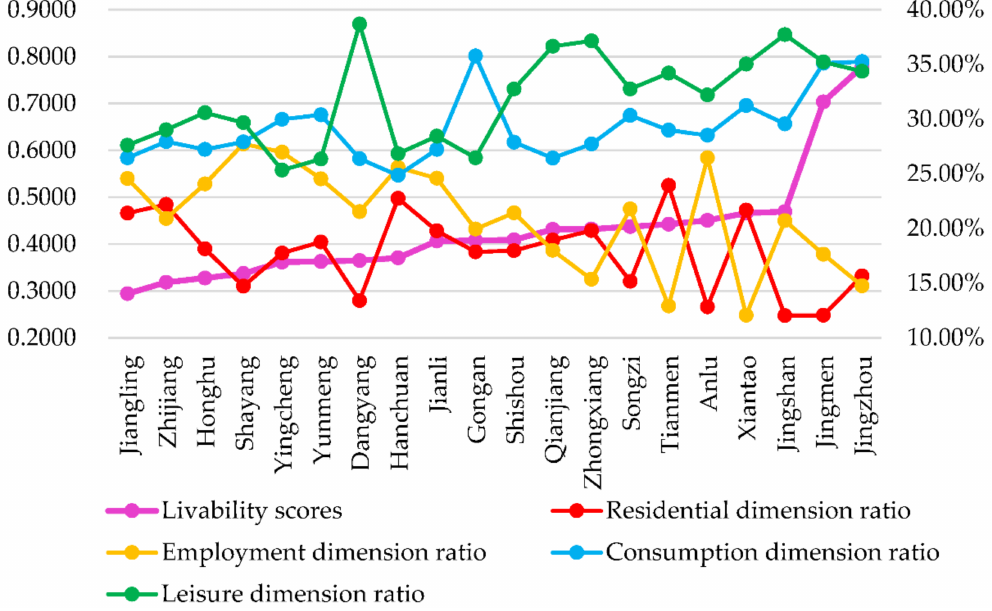
Figure 4. Livability scores and percentage of livability scores of subdimensions in Jianghan